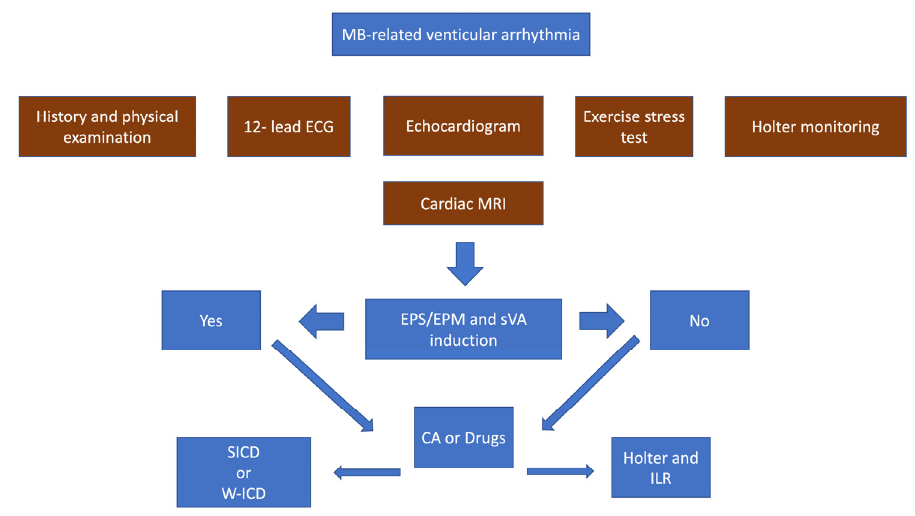
Figure 4. Comprehensive list of examinations and therapeutic strategies available for the manage- ment of patients with MB-related ventricular arrhythmias. EPS: electrophysiological study; electro- physiological mapping; sVA: sustained ventricular tachycardia; SICD: subcutaneous implantable de fi brillator; W-ICD: wearable ICD; ILR: implantable loop recorder; CA: catheter ablation.